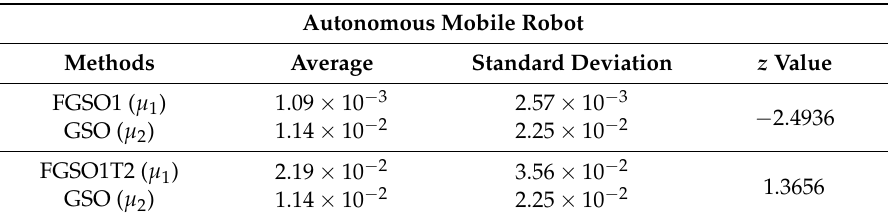
Table 5. Results for the z test with FGSO1, FGSO1T2 and the GSO without noise.